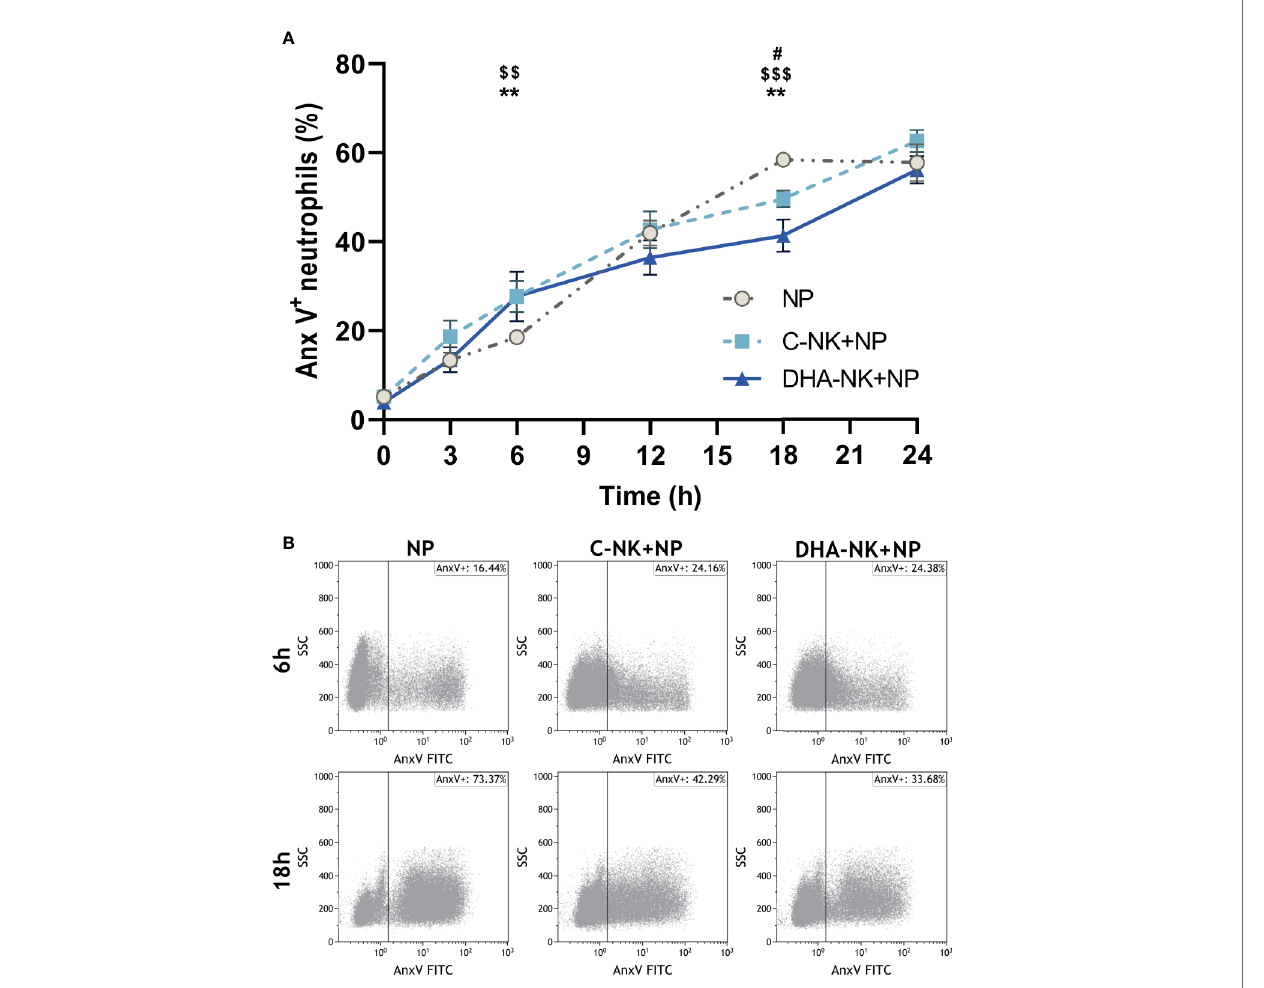
FIGURE 3 | The effects of NK cells and NK cells pre-incubated with DHA on neutrophil apoptosis. Neutrophils were cultured alone (NP), or with NK cells that had been pre-incubated for 18 h without (C-NK+NP) or with 50 µM docosahexaenoic acid (DHA-NK+NP) and then stimulated with IL-2 (2 ng/ml), IL-12 (2 ng/ml), and IL- 15 (10 ng/ml). The cells were cultured together for 0, 3, 6, 12, 18, and 24 h. Apoptosis was determined by fl ow cytometric analysis of annexin V (Anx V) binding to neutrophils and are presented as Anx V + neutrophils (A) . Representative dot plots of Anx V binding to neutrophils after 6 and 18 h of co-culture (B) . Positive gating was determined with an unstained control. Data are shown as mean ± SEM; * indicates difference between C-NK+NP and NP, $ difference between DHA-NK+NP and NP, and # difference between DHA-NK+NP and C-NK+NP. One symbol indicates p < 0.05, two symbols p < 0.01, and three symbols p < 0.001. n = 8 (independent donors), collected in 4 independent